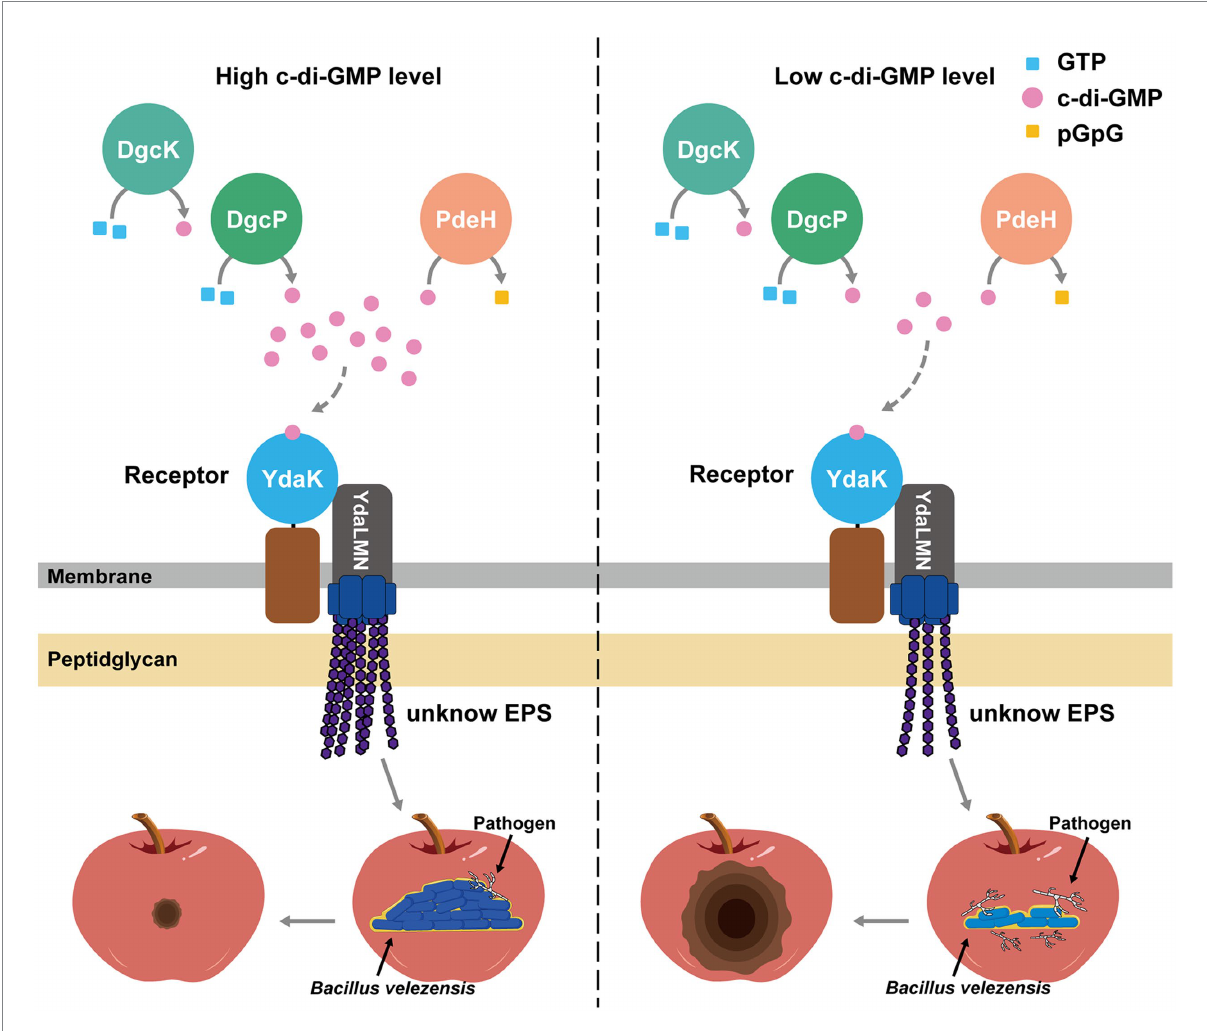
FIGURE 12 Model of c-di-GMP-dependent regulation of biocontrol efficacy via YdaK in B. velezensis . Two diguanylate cyclases (DGCs; DgcK, DgcP) synthesize c-di- GMP from GTP. The sole phosphodiesterases (PDE) PdeH degrades c-di-GMP into pGpG. The formation of the complex between the c-di-GMP